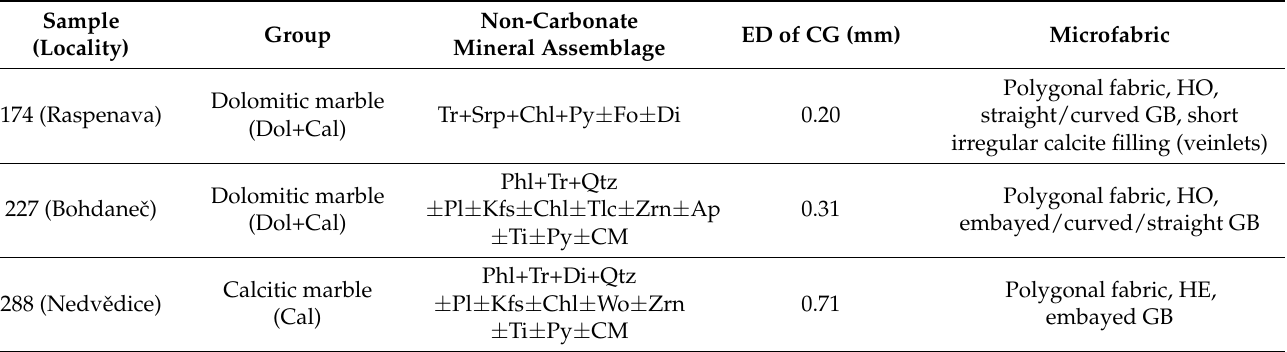
Table 2. Mineralogical-petrographic characteristics of studied samples. Data were adopted from [23]. Ab- breviations: CG—carbonate grains, ED—equivalent diameter (mean of at least 800 CG from each locality obtained by petrographic image analysis), GB-grain boundaries, HE—heteroblastic (i.e., CG of different size), HO—homeoblastic (i.e., CG of uniform size), S. No.—sample code. Mineral phases: